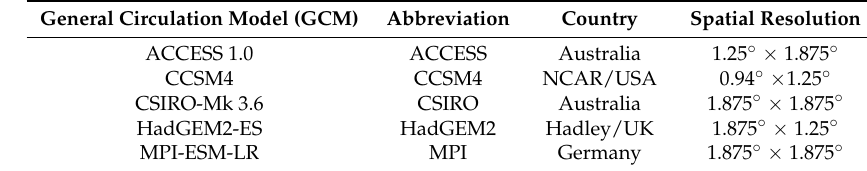
Table 2. Description of the GCMs used in this study.